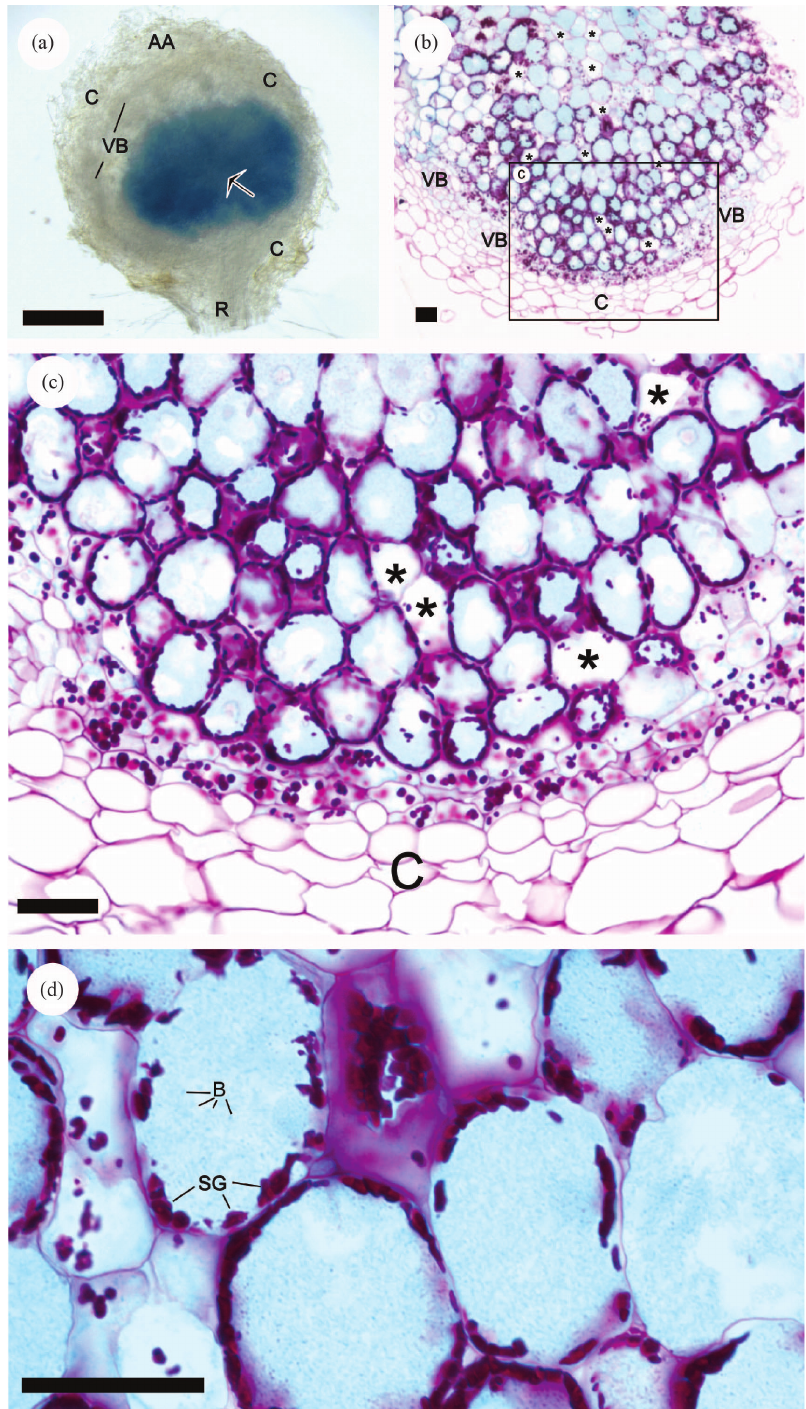
Figure 5. Overview and thin sections of pea nodules after inoculation with Sphingomonas sediminicola [pOPS0385] expressing a GUS reporter gene. ( a ) View of the nodule in which GUS enzyme activity (blue staining) was detected in the central zone, while the roots (R), apical area (AA), cortical cell layers (C), and vascular bundles (VB) remained unstained. ( b – d ) Thin sections of a nodule counterstained with periodic acid–Schiff (PAS) show that GUS activity was only detected in the central area ( b , c ). Most of the blue staining was associated with a granular texture ( d ) compatible with the GUS signal inside bacteria (B), while no signal was seen in the cortical cell layers (C), the vascular bundle (VB), nor in some cells containing large vacuoles (*). PAS counterstaining revealed the presence of numerous starch granules (SG). Bars represent 500 µ m ( a ) or 50 µ m ( b – d